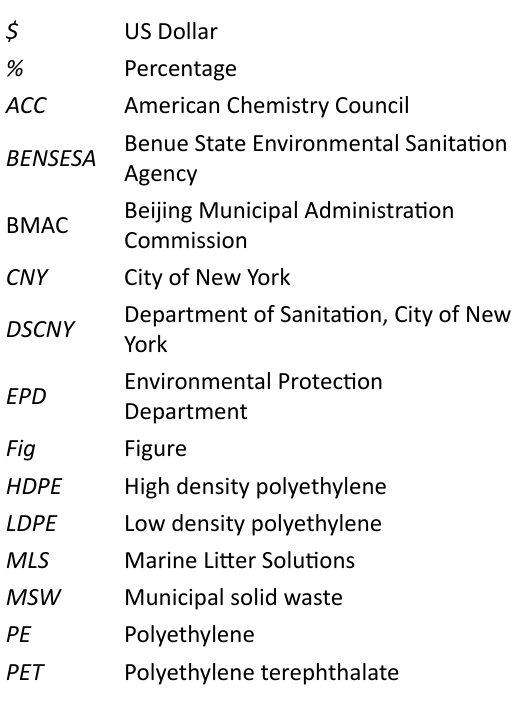
HDPE High density polyethylene